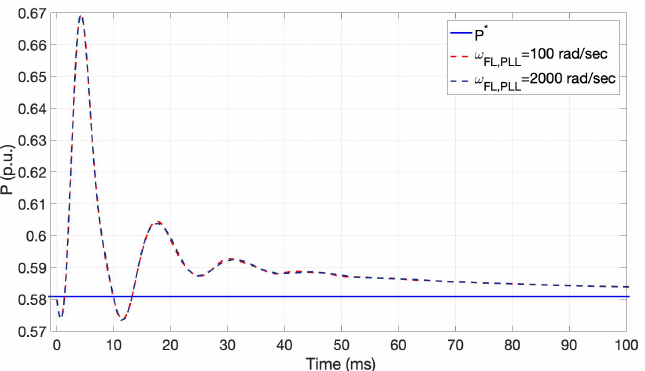
Figure 21. Time domain response of the active power for AIC-PLL for step change in Z g = 1.7 2 p.u. and for different values of the ω FL , PLL .